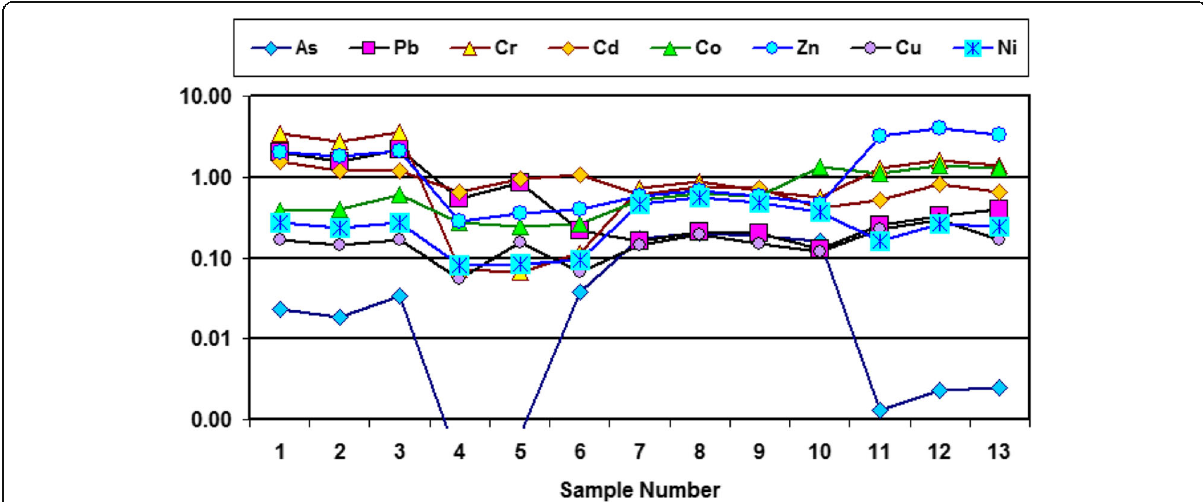
Fig. 5 Enrichment factor of the heavy metals of the studied samples